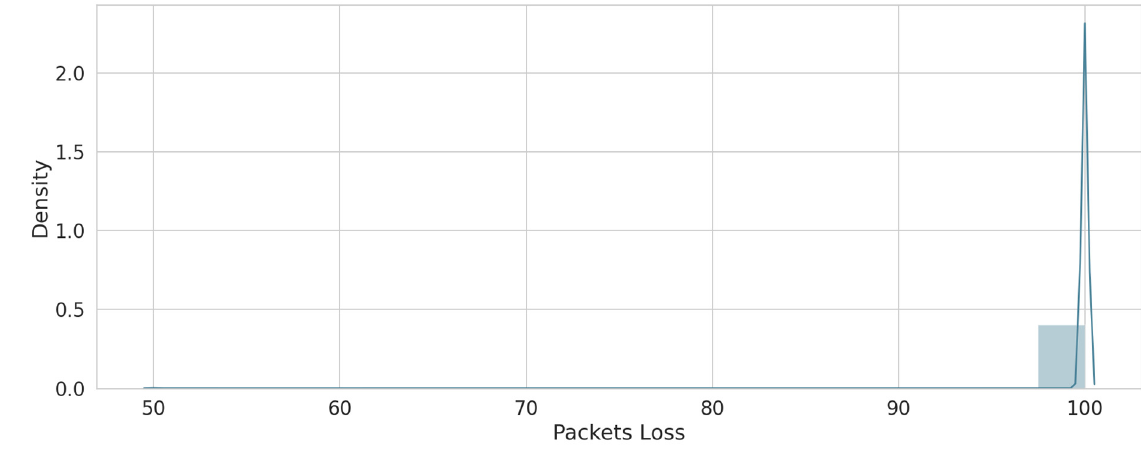
Figure 5. Packets loss sample.